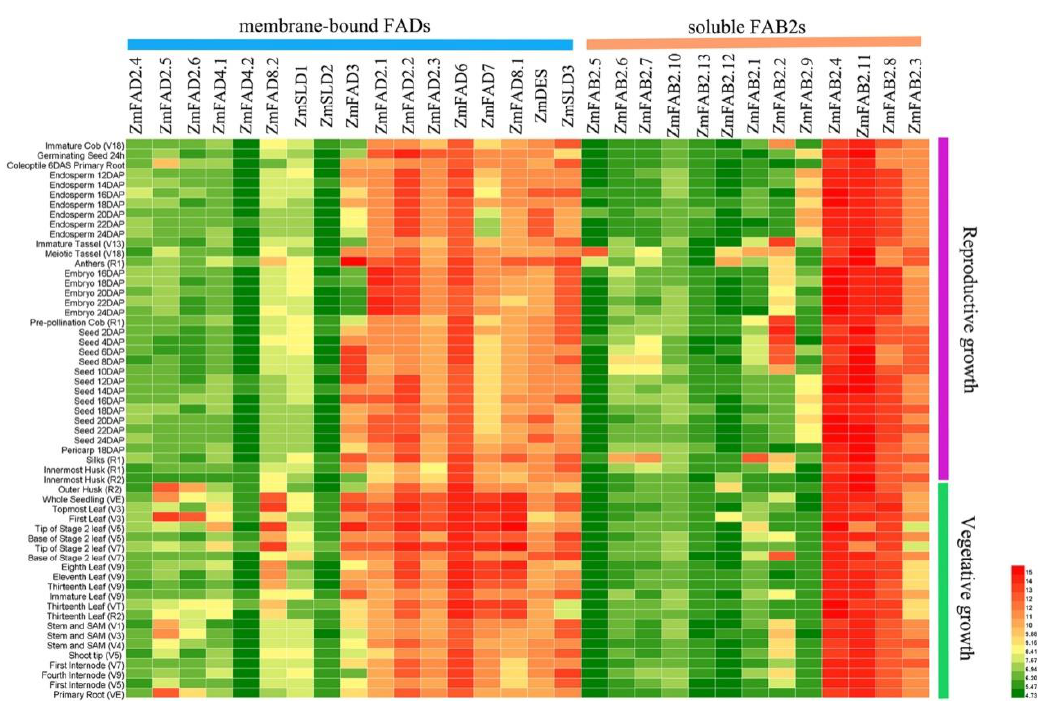
Figure 5. Heat map of expression levels of maize FAD and FAB2 genes in different tissues or at different growth stages. The red boxes indicate high transcript levels, and green boxes indicate low transcript levels.